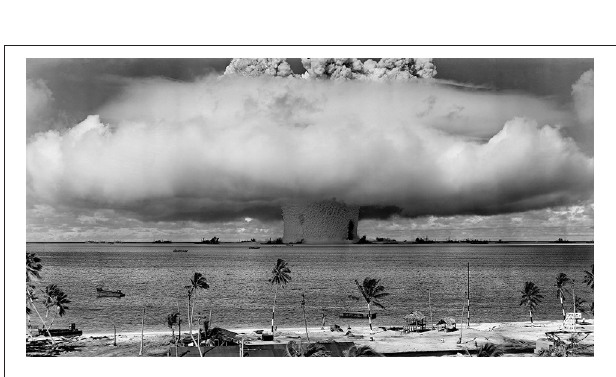
FIGURE 3 | Test Baker, Bikini, July 25, 1946 (U.S. National